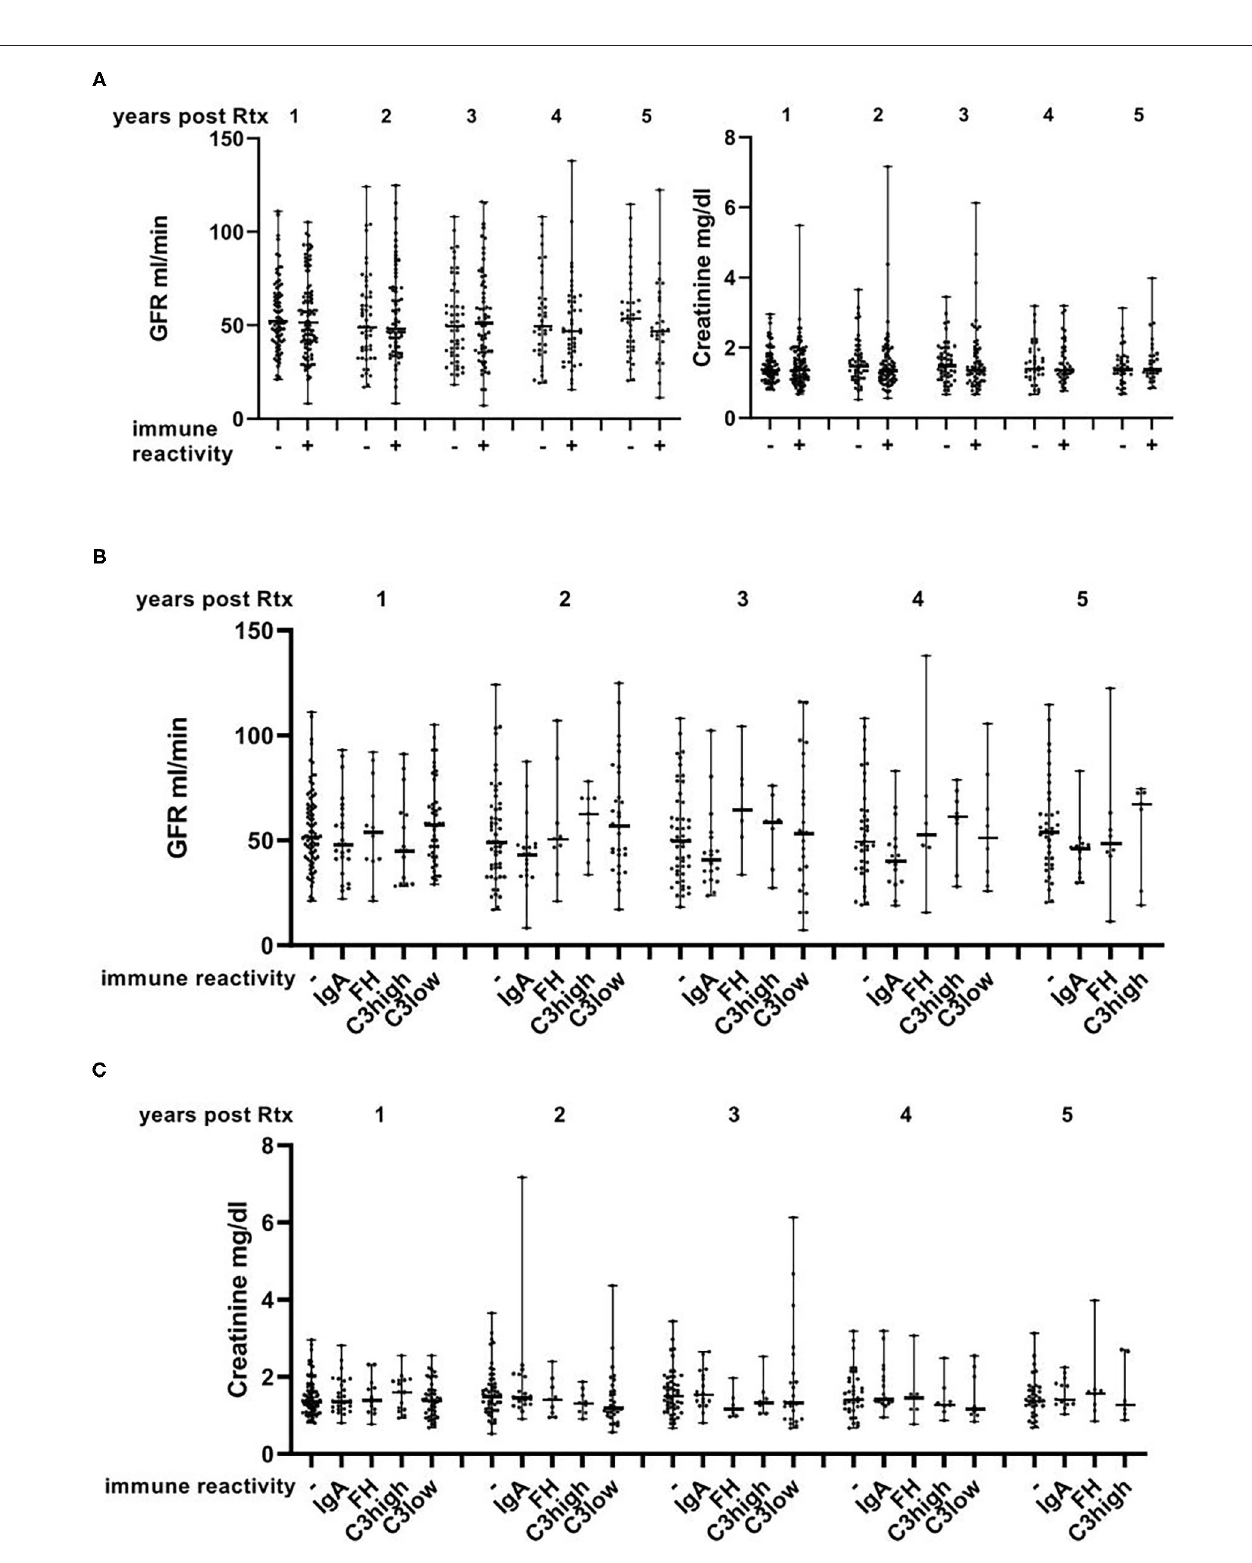
FIGURE 4 | Course of GFR and creatinine in the first 5 years after transplantation. No differences with regard to GFR and creatinine were observed between cases that were positive and negative for immune reactivity (A) or across the different assessed subgroups (B,C) and no apparent overall deterioration of the renal function. Data are shown with median and